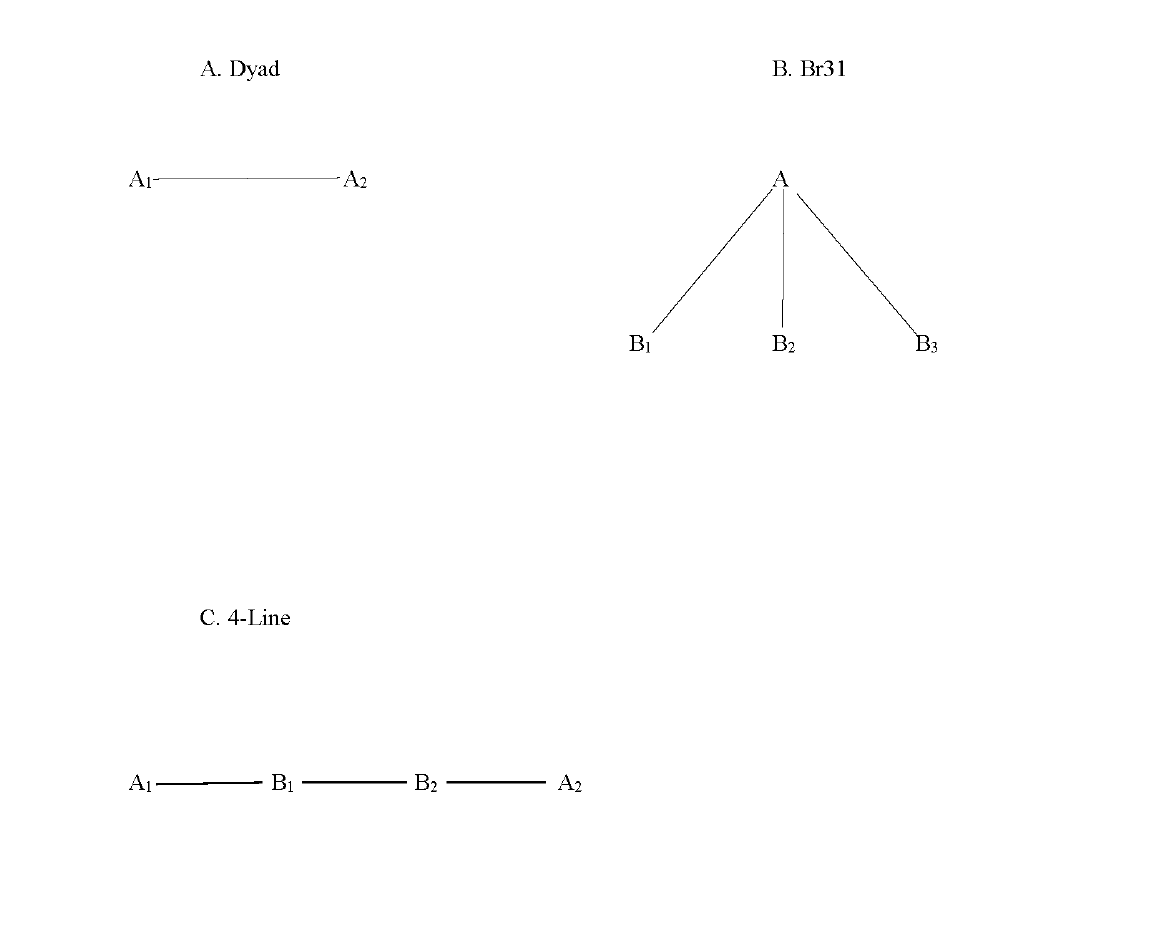
Figure 1: Structures used in exchange